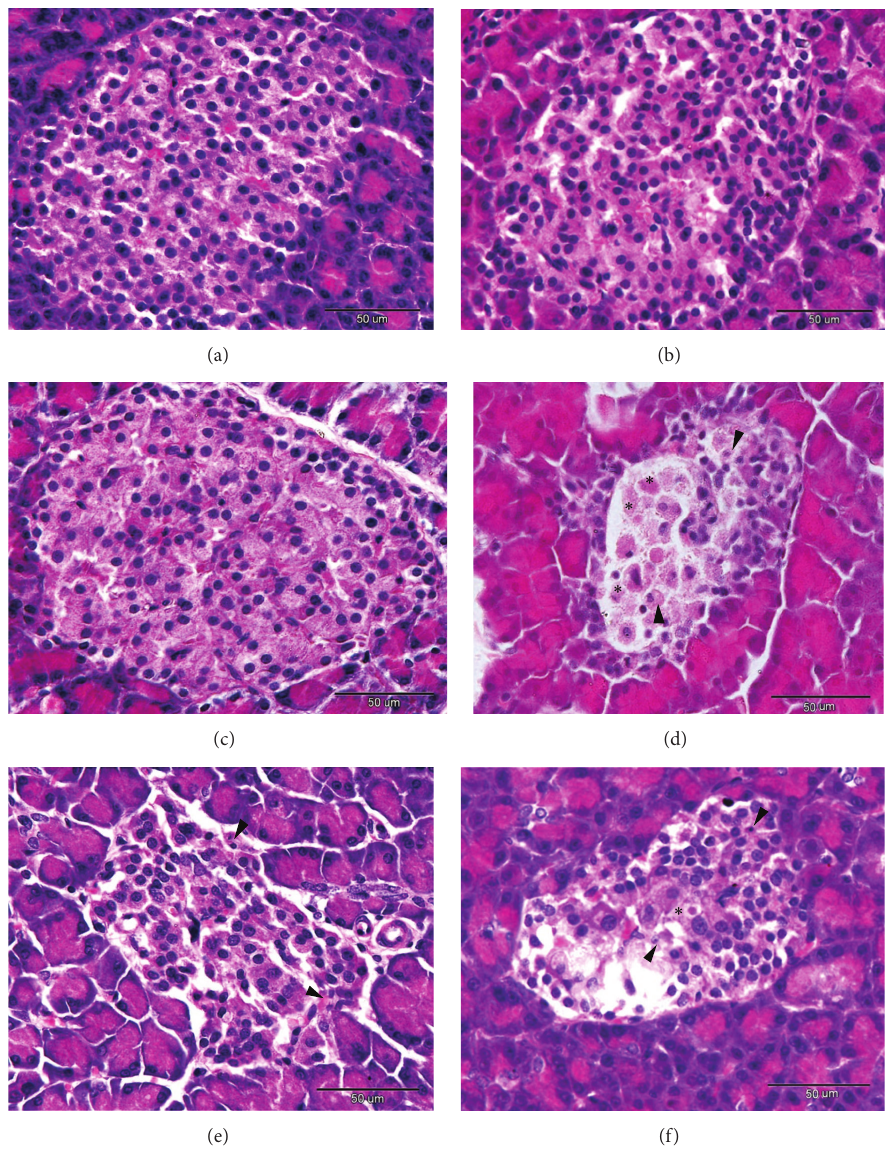
Figure 9: ((a)–(d)) A photomicrograph of the pancreas of NC group (a), BAETN group (b), and the PSETN group (c). The diabetic pancreas (d) showed severe necrotic and degenerative changes (arrowheads). Residues of the cytoplasm and the nuclei were also seen (asterisks). In the BAETD and PSETD groups ((e) and (f), resp.), the degenerative and necrotic changes were markedly lower than that observed in the DC group, H&E staining. Scale bar = 50 𝜇